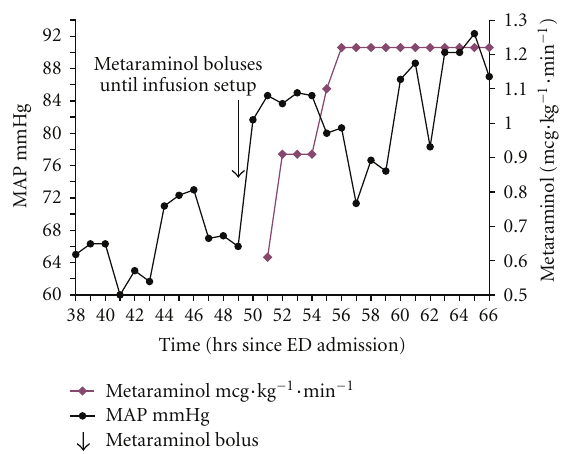
Figure 3: MAP after starting metaraminol infusion (hours 38– 66). Note left y -axis MAP in mmHg, right y -axis metaraminol in mcg · kg − 1 · min − 1 . Arrows show metaraminol boluses.